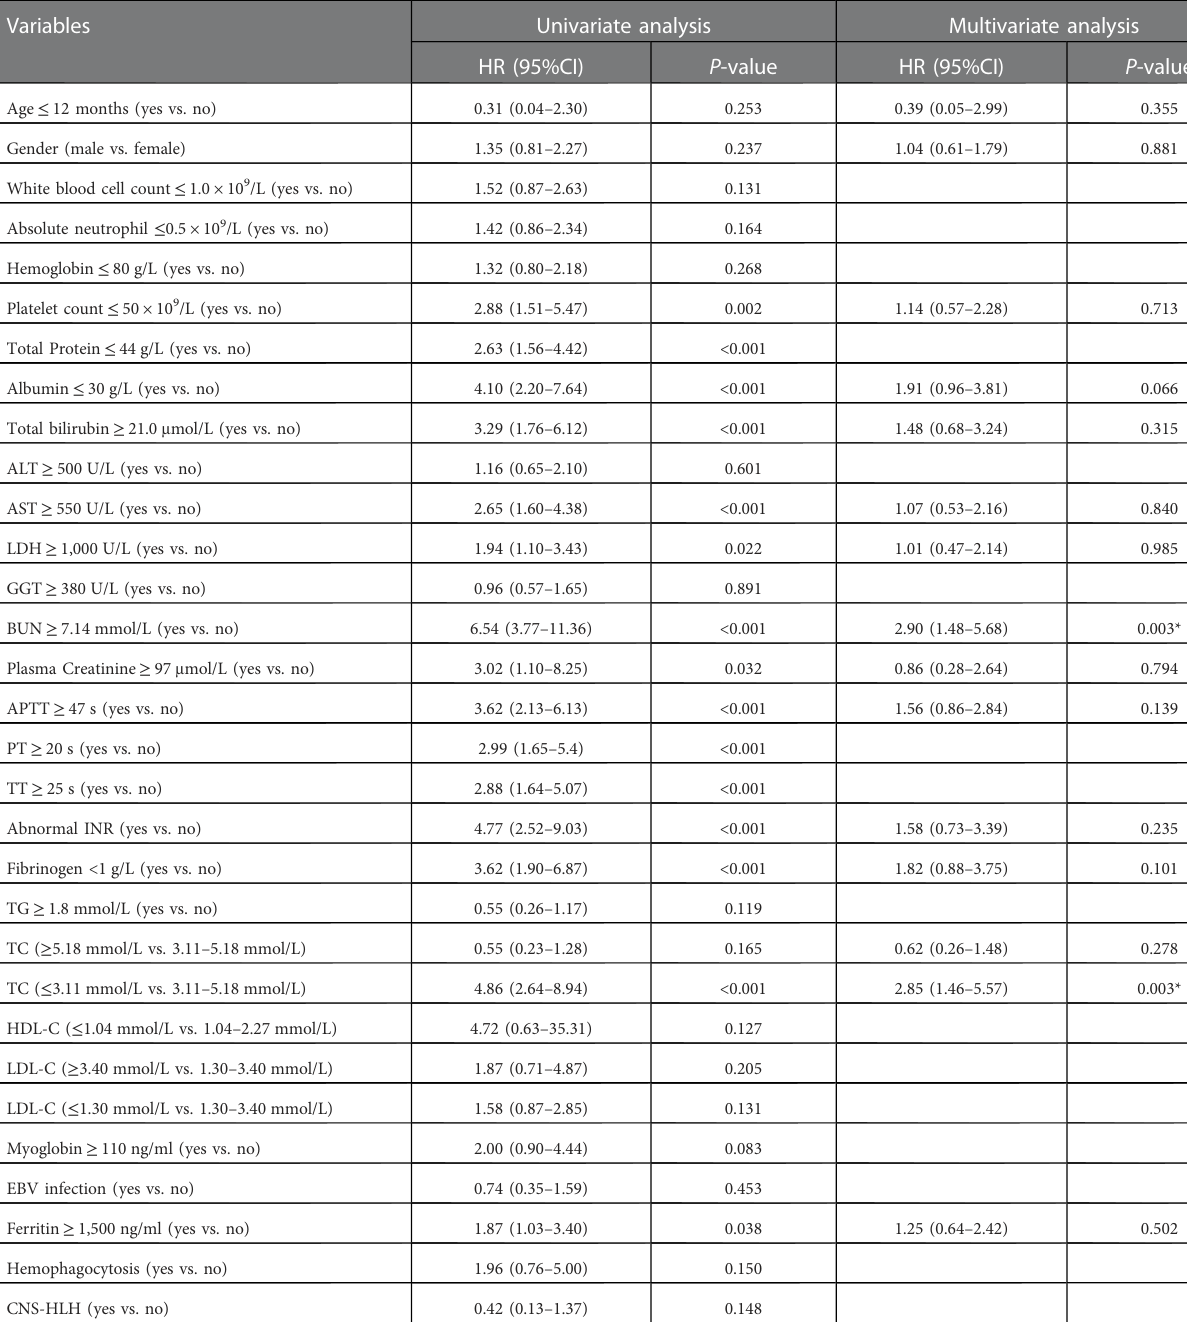
TABLE 3 Risk factors for 30-day mortality by univariable and multivariable Cox regression analyses in 353 HLH patients. Variables Univariate analysis Multivariate